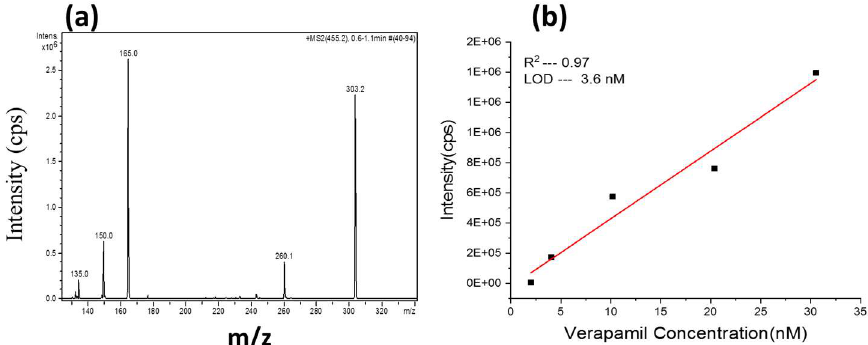
Figure 5. MS spectra for Verapamil ( a ) internal standards were protonated verapamil at m/z 455.3 ( b ) Limit of detection for S/N of 2.5 was 3.6 nM with correlation coefficient of 0.97.